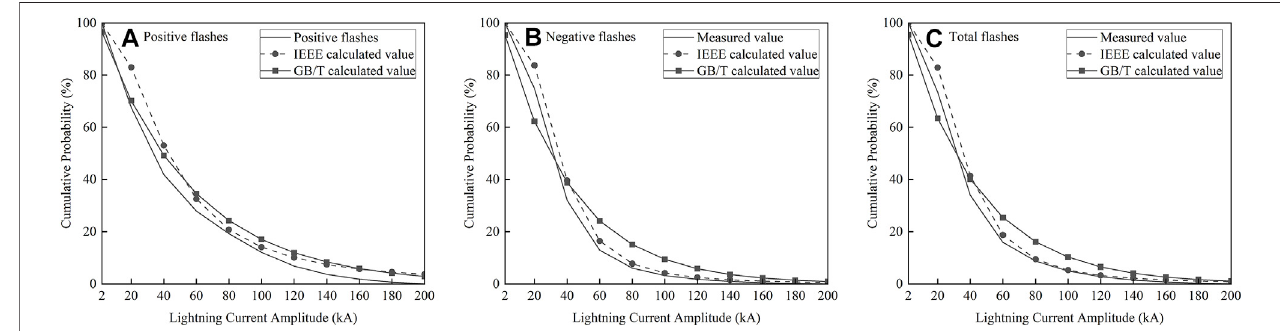
FIGURE 6 | Comparison of the cumulative probability distribution between measured values and calculated values in 2020 (A) Positive fl ashes, (B) Negative fl ashes, and (C) Total fl ashes.